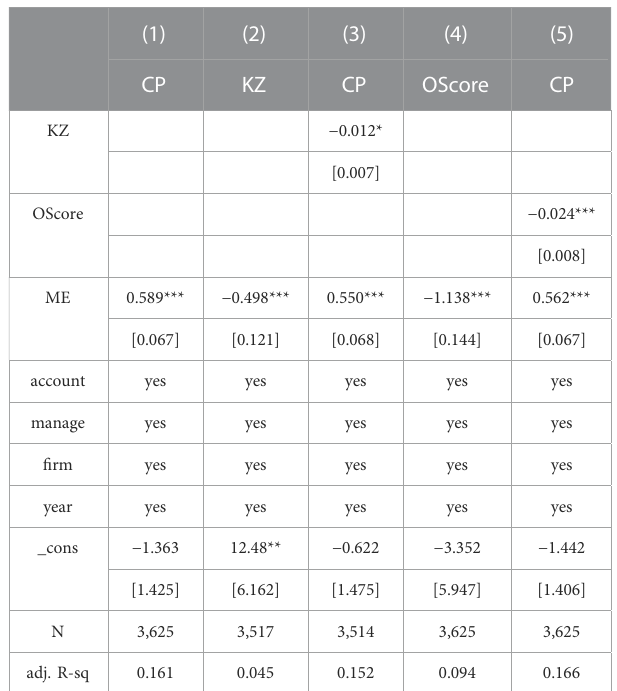
TABLE 6 Robustness tests. TABLE 7 Intermediary